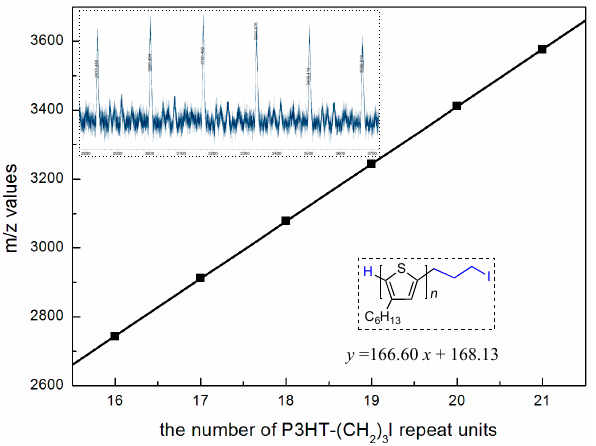
Figure 3. MALDI-TOF spectrum (inset) of macromer P3HT-(CH 2 ) 3 I (MW~2000 g/mol by NMR) and plot of m / z values ( y axis) vs. the number of P3HT repeat units ( x axis).